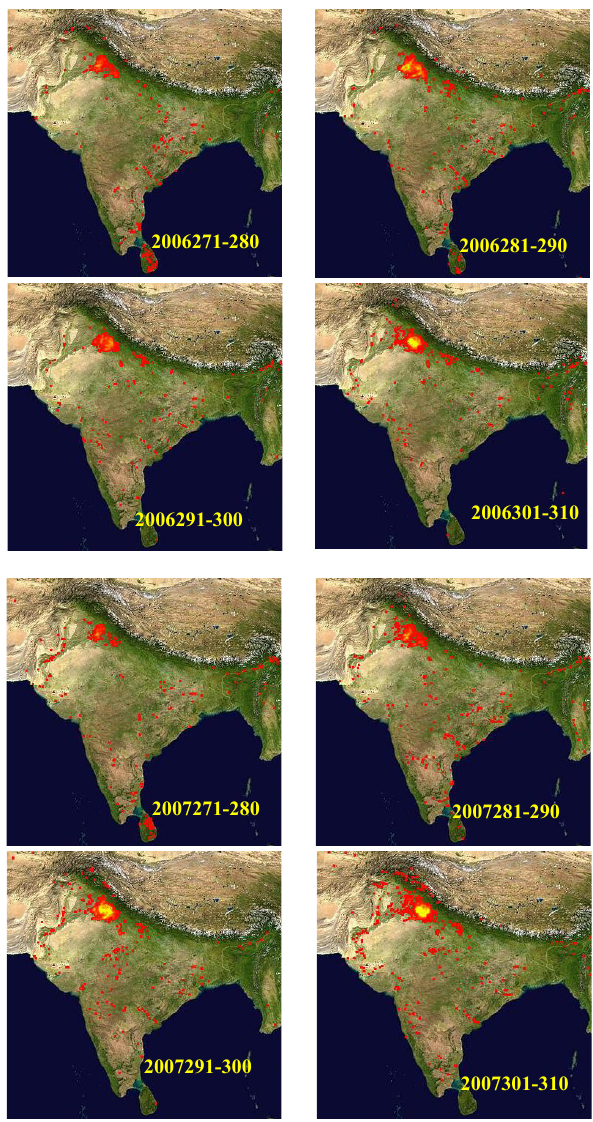
Fig. 13. MODIS active fires composite during October 2006 and 2007 showing increased occurrence of fires during October 2007.